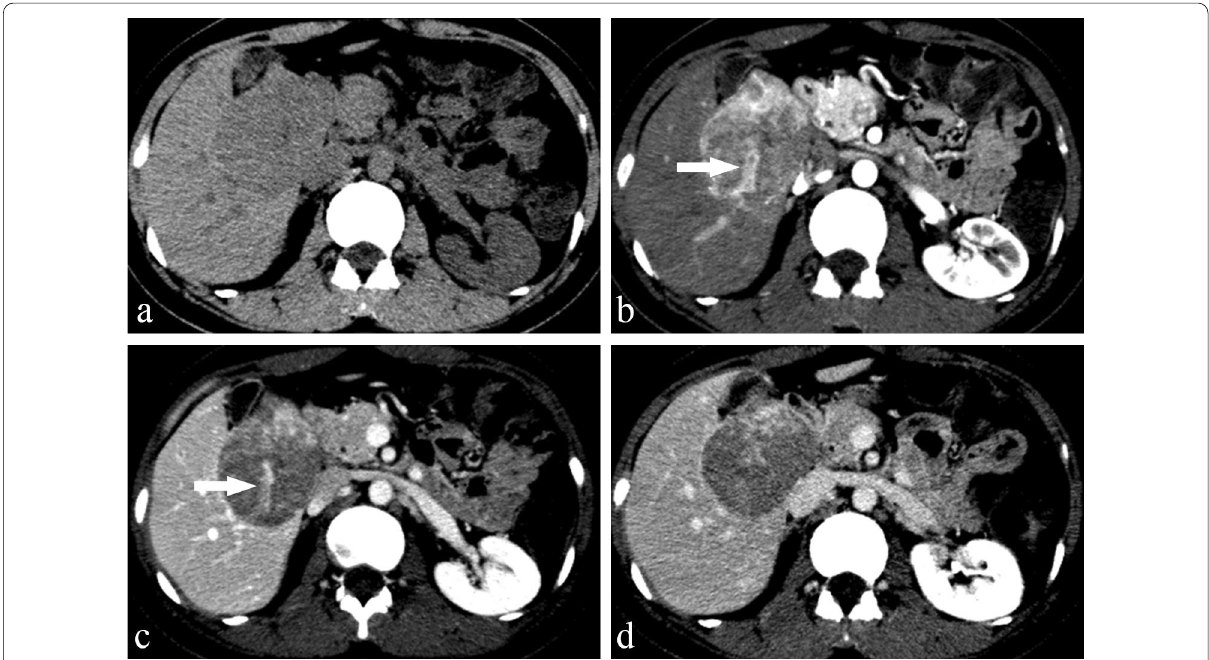
Fig. 1 A 24-year-old female with pathologically diagnosed HEHE. a Axial unenhanced CT shows an isolated mass in the centre of the liver. Marked enhancement on the arterial phase, ( b ) of the whole tumour, and washout occurred quickly in the next two phases ( c , d ). Enlarged, persistently enhancing blood vessels are seen within the tumour ( arrows, b , c